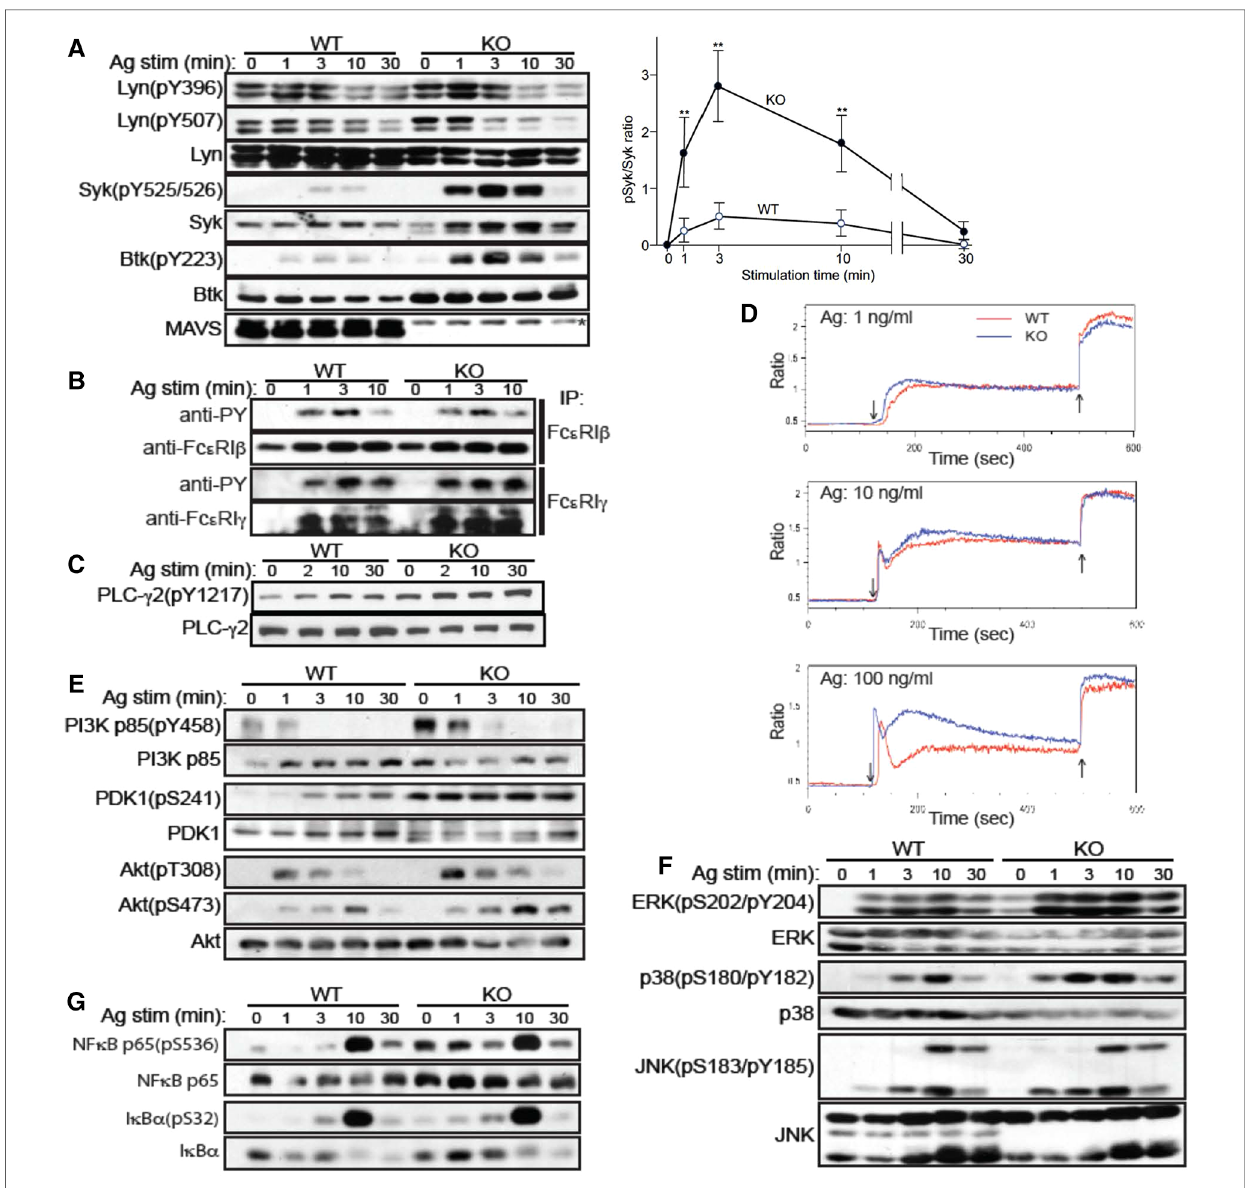
FIGURE 2 Fc ϵ RI-stimulated MAVS-de fi cient mast cells exhibit dramatically enhanced Syk activation. ( A-C, E-G ) WT and MAVS − / − BMMCs were sensitized with IgE and stimulated with Ag (100 ng/ml of DNP 23 -HSA). Cells were lysed, and cleared lysates were either directly analyzed by SDS-PAGE followed by western blotting ( A,C,E-G ) or fi rst immunoprecipitated (IP) before the precipitates were analyzed by SDS-PAGE ( B ). Proteins detected by antibody are indicated on the left of the gels. ( D ) IgE-sensitized BMMCs were loaded with Indo-AM and stimulated with Ag ( ↓ ), followed by ionomycin ( ↑ ). Fluorescence ratio (525:405 nm) was measured by fl ow cytometer. Results representative of two independent experiments are shown except for Syk phosphorylation, which was con fi rmed by two additional